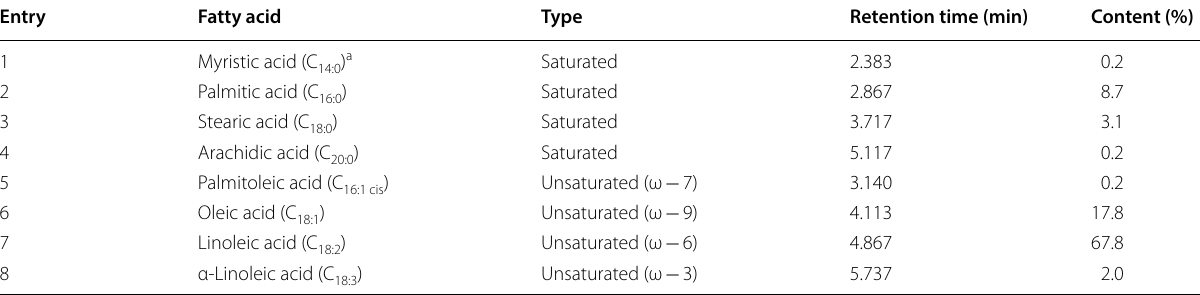
Table 1 Fatty acid composition of seed oil of the C. heratensis seed